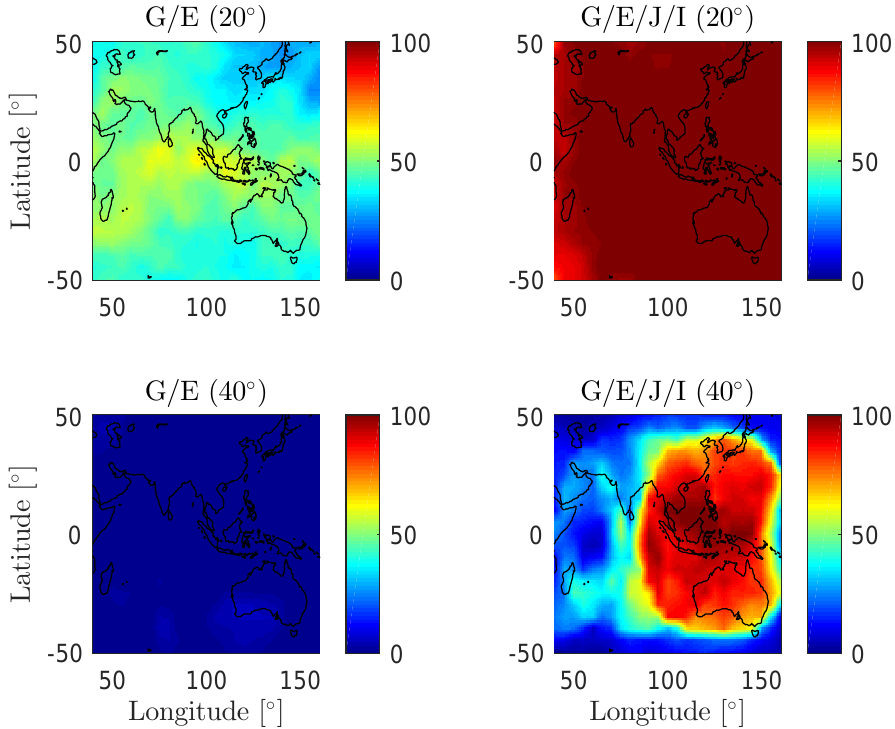
Figure 2. Percentages with the 24 h period that at least eight satellites are above the elevation mask of 20 ( top ) and 40 degrees ( bottom ). The figure was generated based on the MGEX combined broadcast ephemeris on DOY 224, 2018 with a data sampling interval of 30 s. The newly launched I09 and the QZSS satellite J07 were not contained in the broadcast ephemeris. The satellite positions (WGS84) of J07 on DOY 154, 2018 were used for the